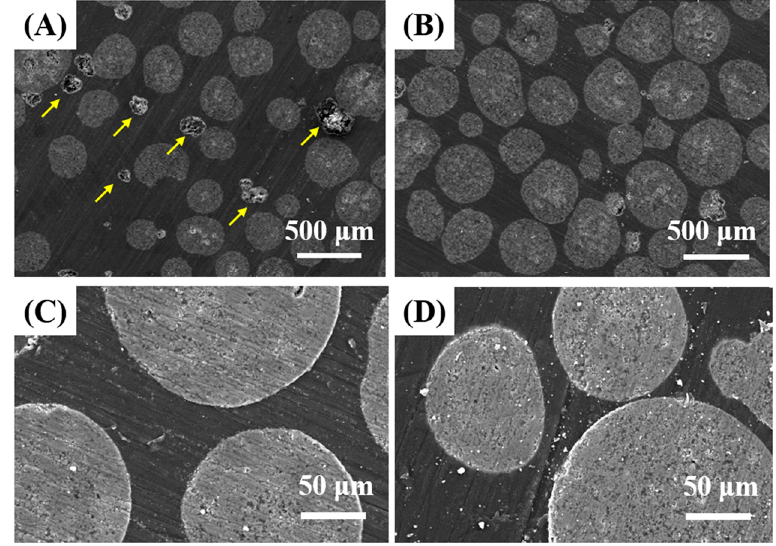
Figure 5. Representative SEM images of PMMA/HA composites produced using the HA microspheres with various HA contents of 20 vol % ( A , C ) and 40 vol % ( B , D ), showing distribution of the HA microspheres in the PMMA matrix ( A , B ) and interfacial bonding between the HA microspheres and PMMA ( C , D ). Yellow arrows indicate voids formed during the grinding process for SEM observations.